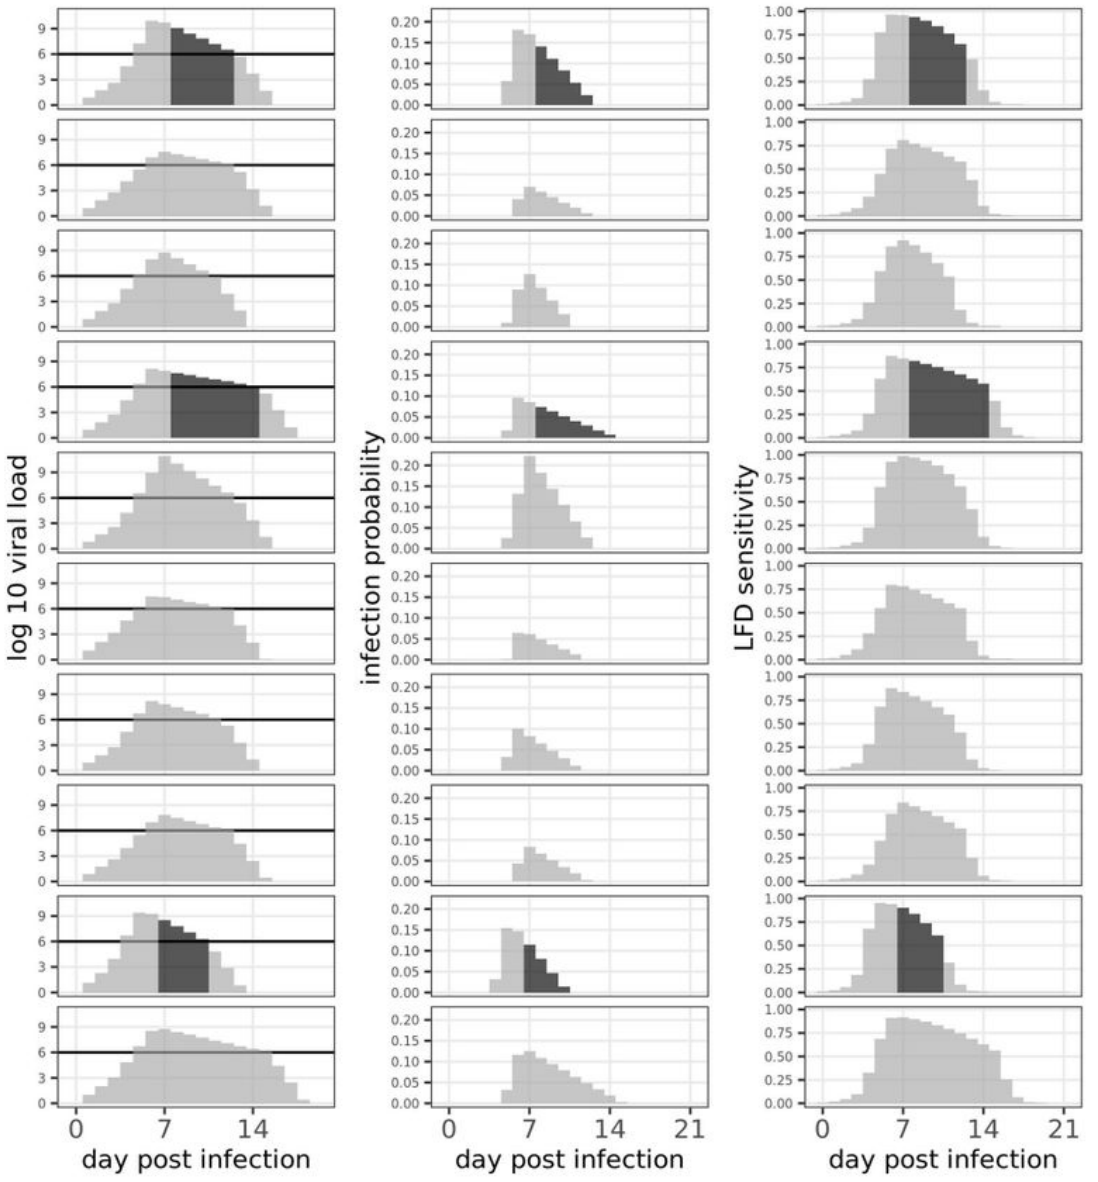
Figure 1. Thirty randomly sampled viral load (VL)-trajectories under the Larremore model, assuming that 50% of children are asymptomatic. Horizontal solid black line corresponds to the default lower limit of infectivity of ; the infection probability is calibrated to a school-level reproduction number of 3 and the mean presymptomatic lateral flow device (LFD) sensitivity is assumed to be 60% (see 2.3, 2.4, and